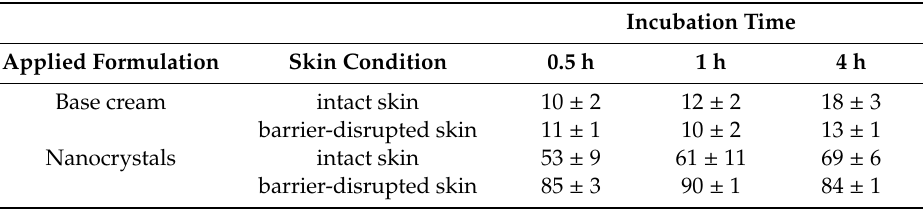
Table 2. Quantitative analysis of absolute spin concentration within the analyzed skin sample ([spins × 10 14 / cm 2 ]) of DxPCA within the whole skin after the removal of the supernatant for the respective incubation time (corresponding to the applied DxPCA amount of 12 ± 1 µg/cm 2 ).